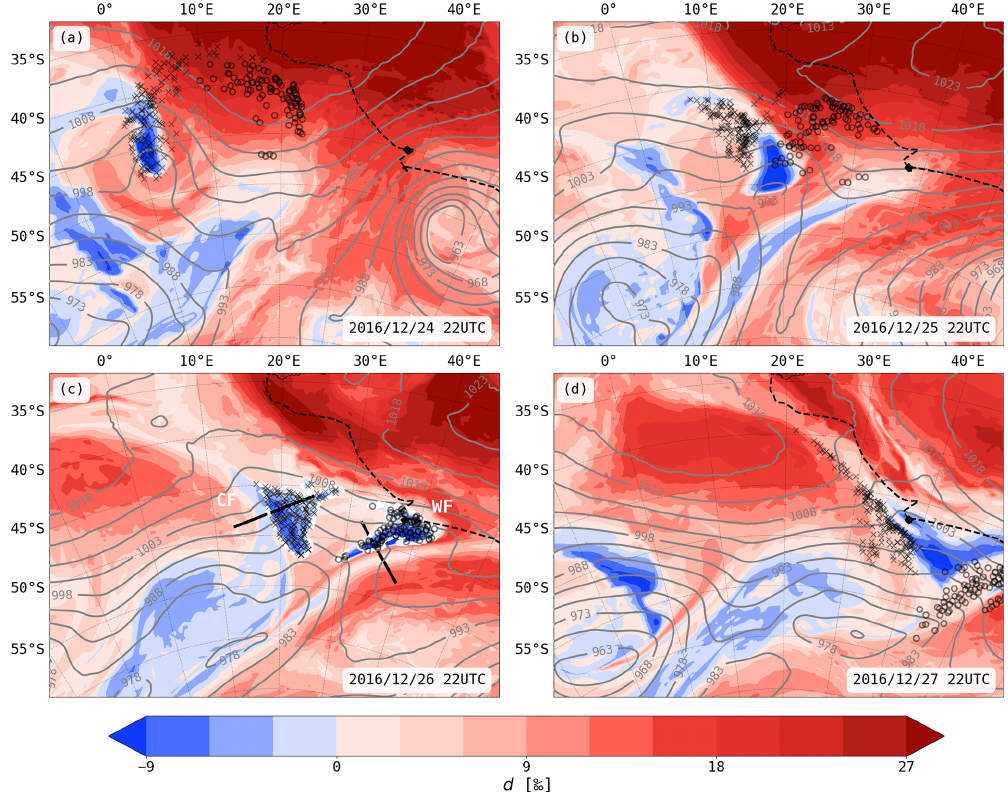
Figure 7. Panels (a) – (d) show horizontal cross sections of d at the lowest model level and sea level pressure (grey contours, in hPa) at four time steps during the warm advection case study. The black dashed line shows the ACE ship track, and the black square denotes the position of the research vessel. The white framed regions in panel (c) show the starting regions WF and CF of the backward and forward trajectories at 22:00UTC on 26 December 2016. Circles and crosses in panels (a) – (d) show the position of trajectories starting below 50ma.s.l. in the regions WF and CF, respectively. The black solid lines in panel (c) denote the positions of the vertical cross section across the cold and warm front, respectively, in Fig.